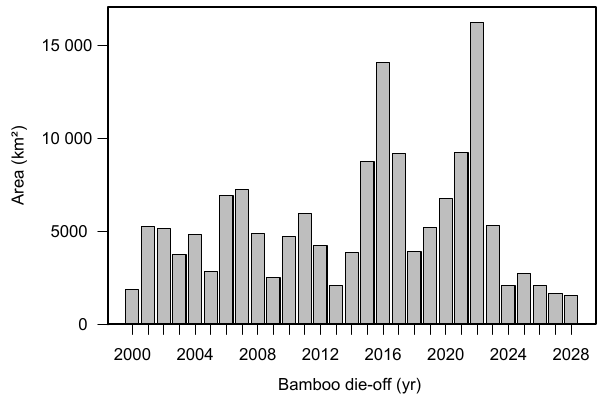
Figure 10. Distribution of predicted bamboo die-off area per year between 2000 and 2028 from MODIS